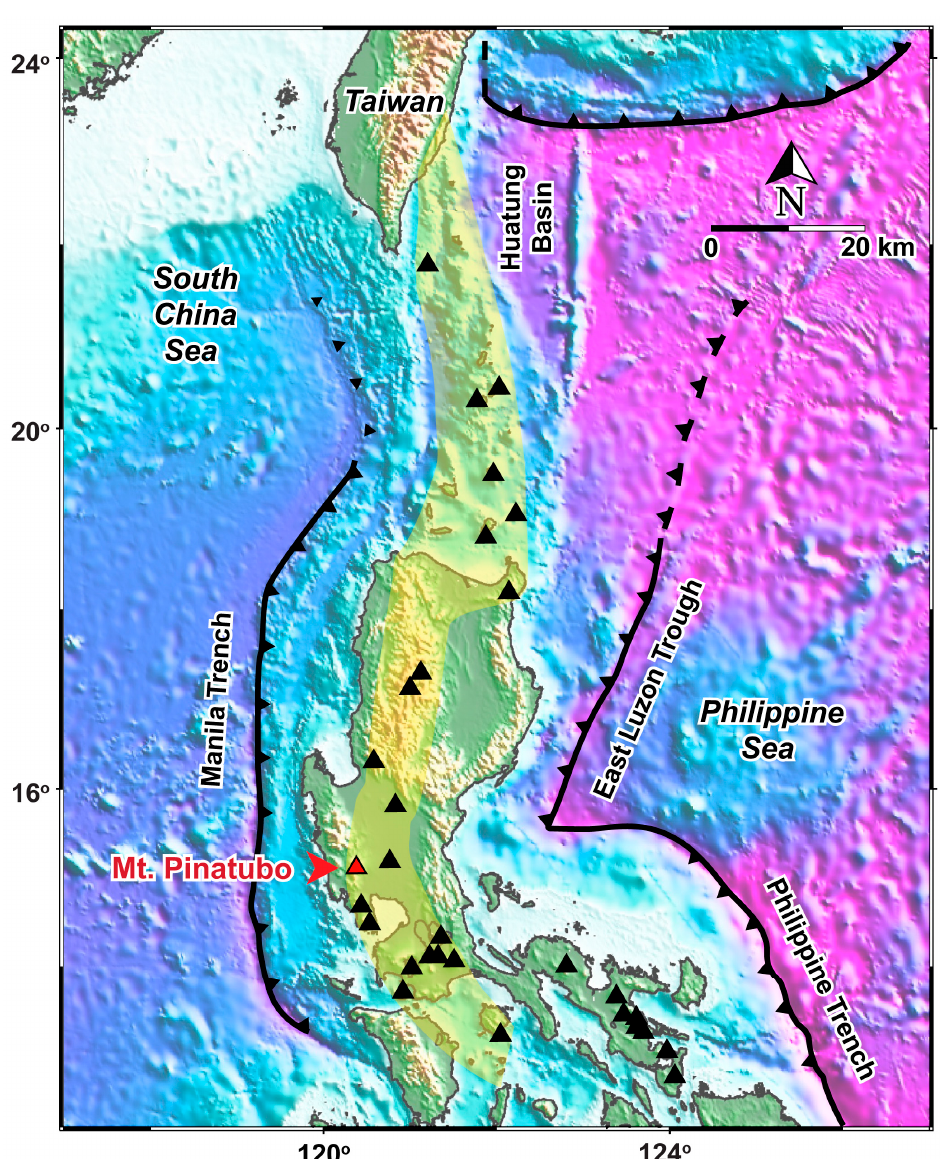
Figure 1. Map showing the location of Mt. Pinatubo (red triangle) in western Luzon. The extent of the Luzon Arc from the Coastal Range, Taiwan to northeastern Mindoro is also shown in yellow. Topographic and bathymetric map for Luzon was generated using Submap 4.1 [41].